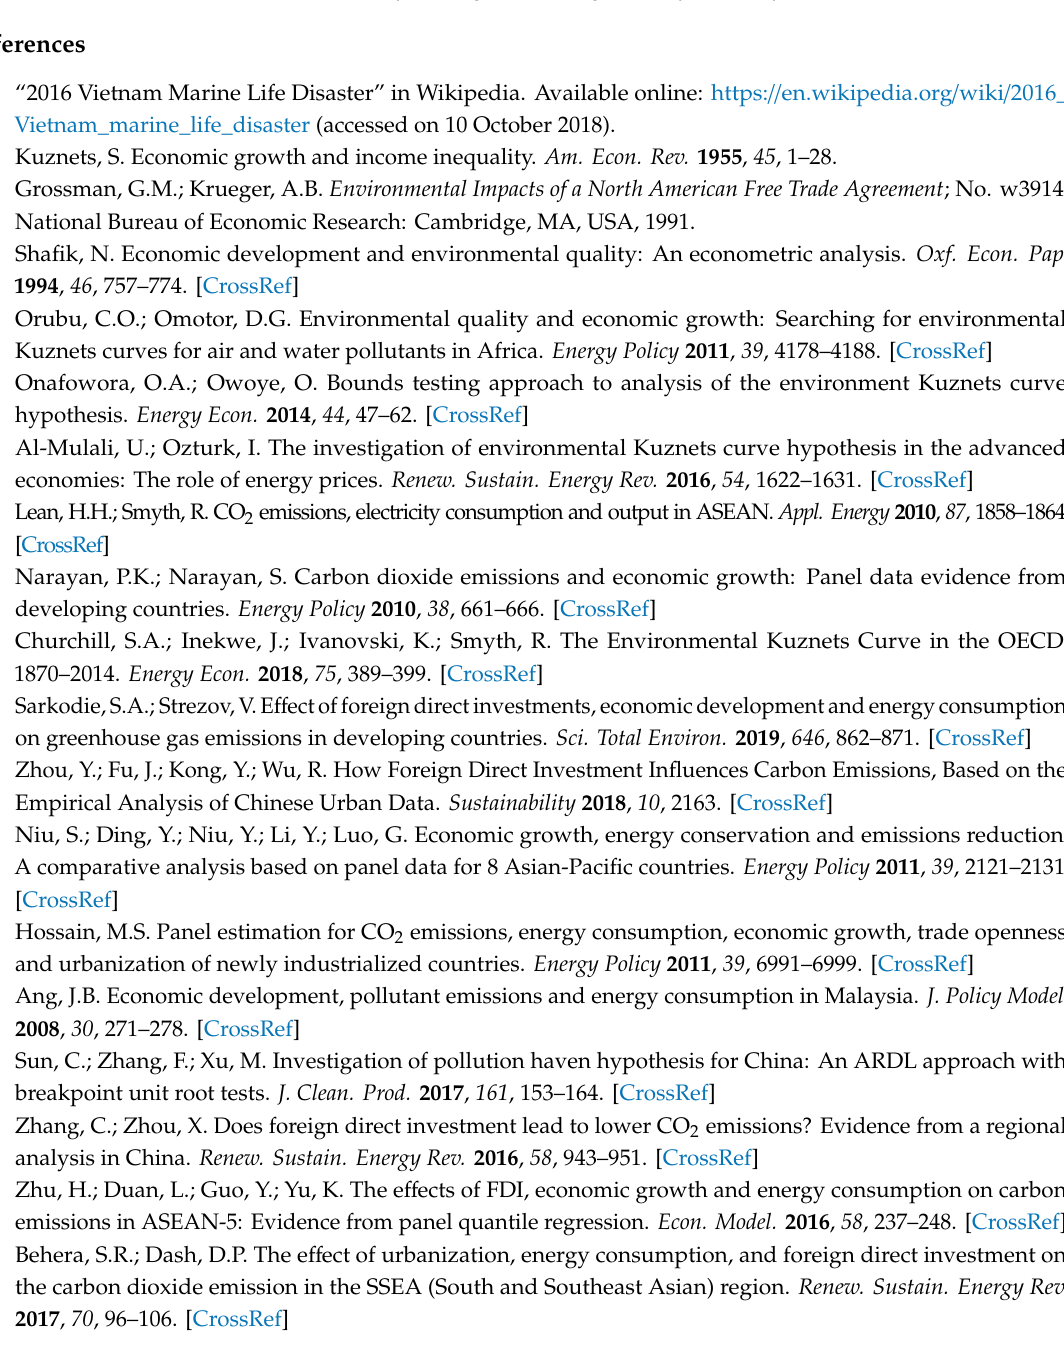
Figure A3. Summary of long ‐ run homogeneously causality test.